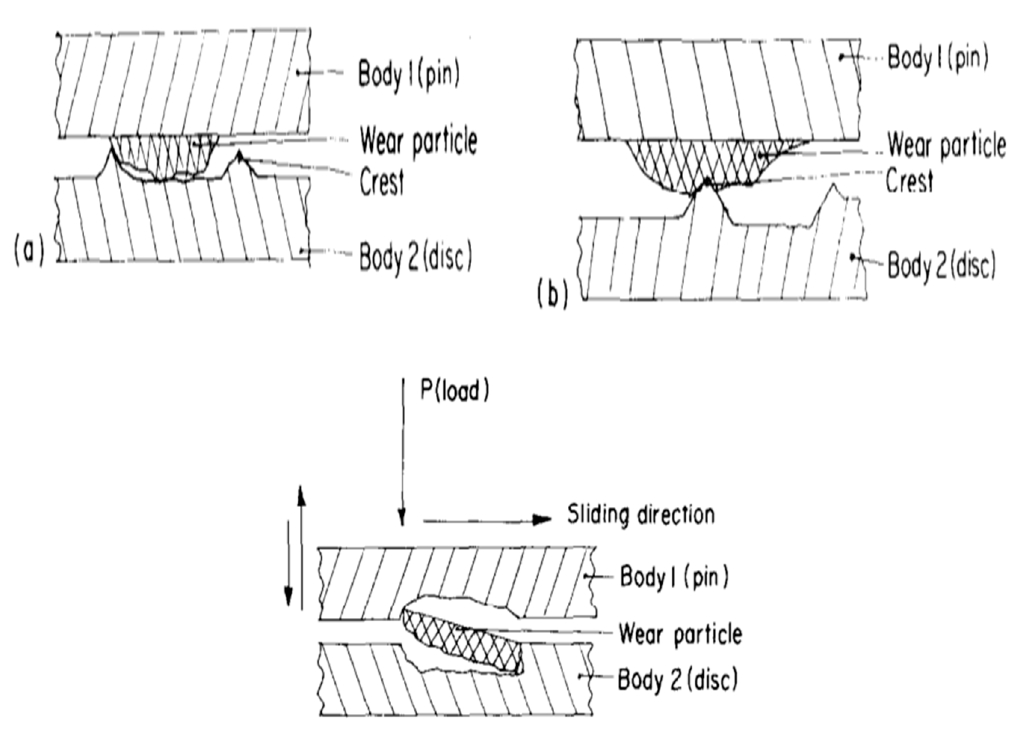
Figure 1. Schematic diagram of particle removal and entrapment. ( a ) Particle removal. ( b ) Two ways of particle entrapment.